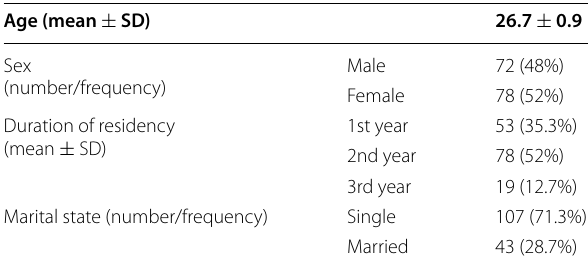
Table 1 Age, gender, marital status, and duration of residency of the residents